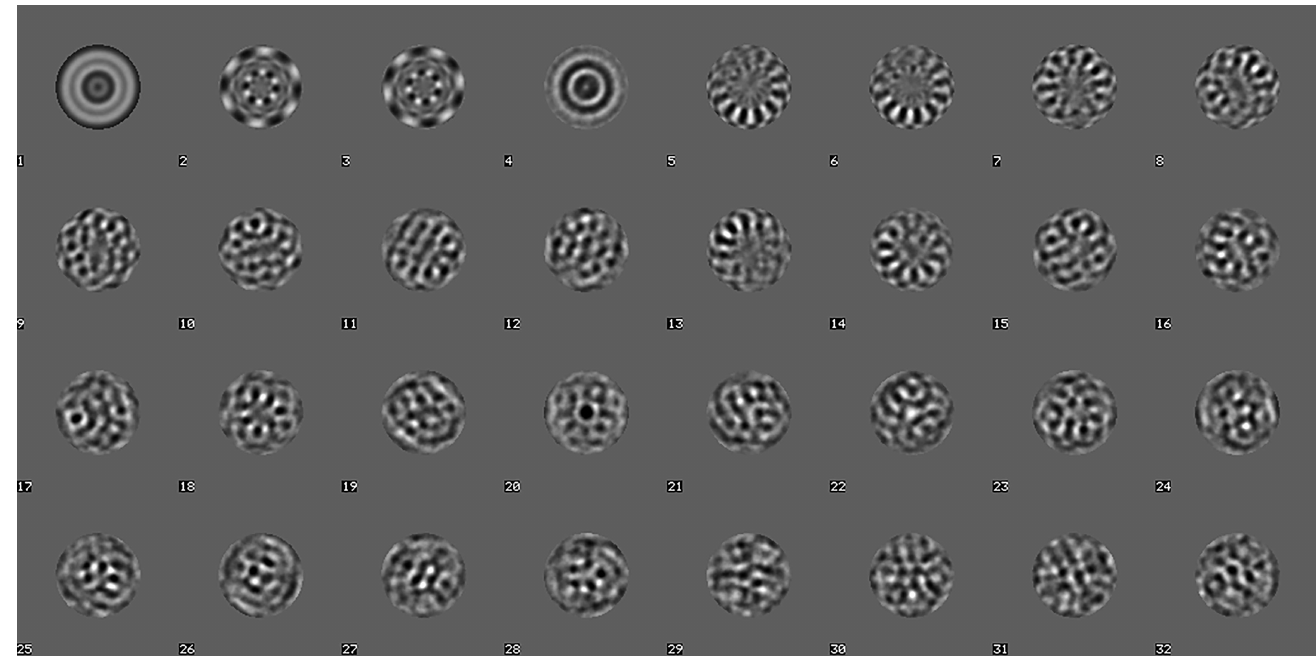
Figure 6 The first 32 eigenimages of 20 000 picked particles. The first eigenimage is rotationally symmetric, reflecting this property of the first set of particle- picking templates. Eigenimages 2 and 3 reflect the predominant sixfold symmetry of the worm-haemoglobin ‘top views’.